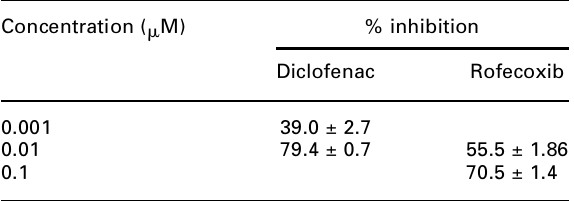
Table 1. Per cent inhibition by diclofenac and rofecoxib of LPS-induced PGE 2 formation in monocytes Concentration ( m